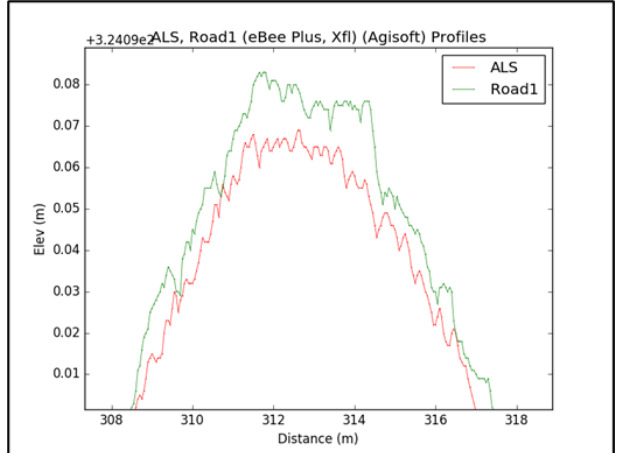
Figure 4. Sample of graphical display of elevation profile differences behavior along road 1 (see Figure 3 for road 1).